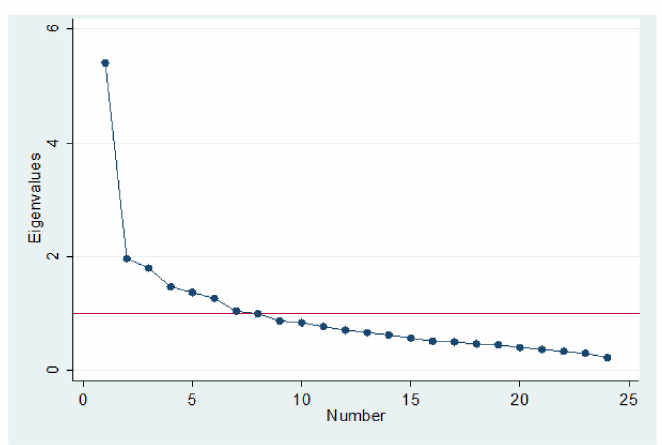
Figure 2. Sedimentation graph of eigenvalues after factor analysis.